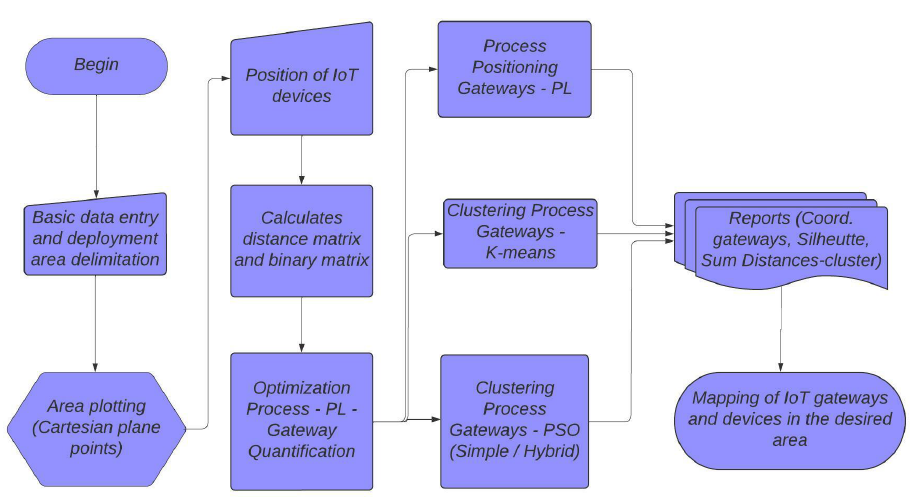
Figure 1. The flowchart of the optimization